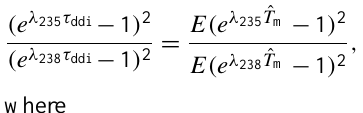
isochron ages; and β the slope of the regression line for the 207 Pb / 204 Pb vs. 206 Pb / 204 Pb